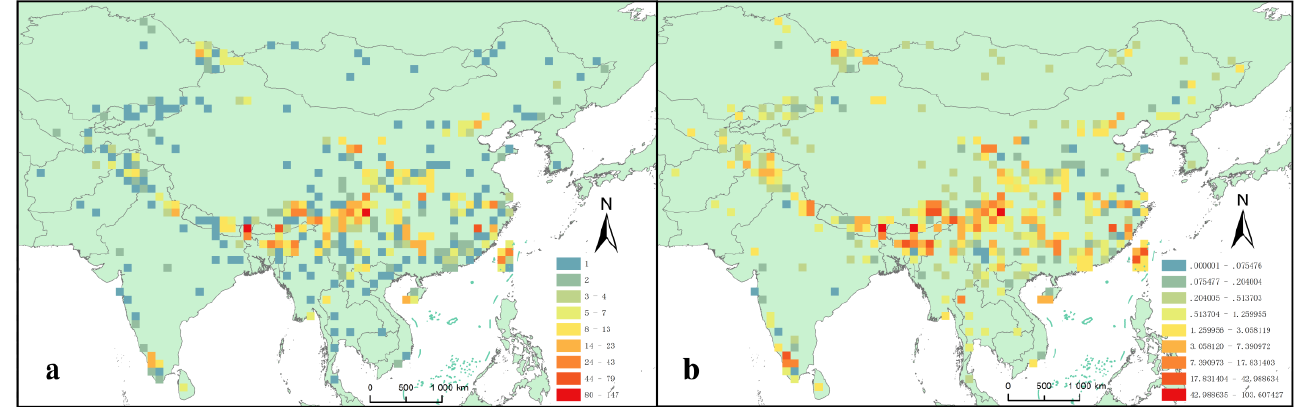
Figure 2. ( a ) Species richness pattern and ( b ) Endemic pattern of Tipulidae in the Qinghai-Tibet Plateau and its surrounding areas. (The numbers in ( a ) are the species richness indices, which represent the number of species; the numbers in ( b ) are the endemic index, which represent the sum of the inverses of the number of grids occupied by all species in the grid.) Dimensions of grids at 1° × 1° (~110 × 110 km).